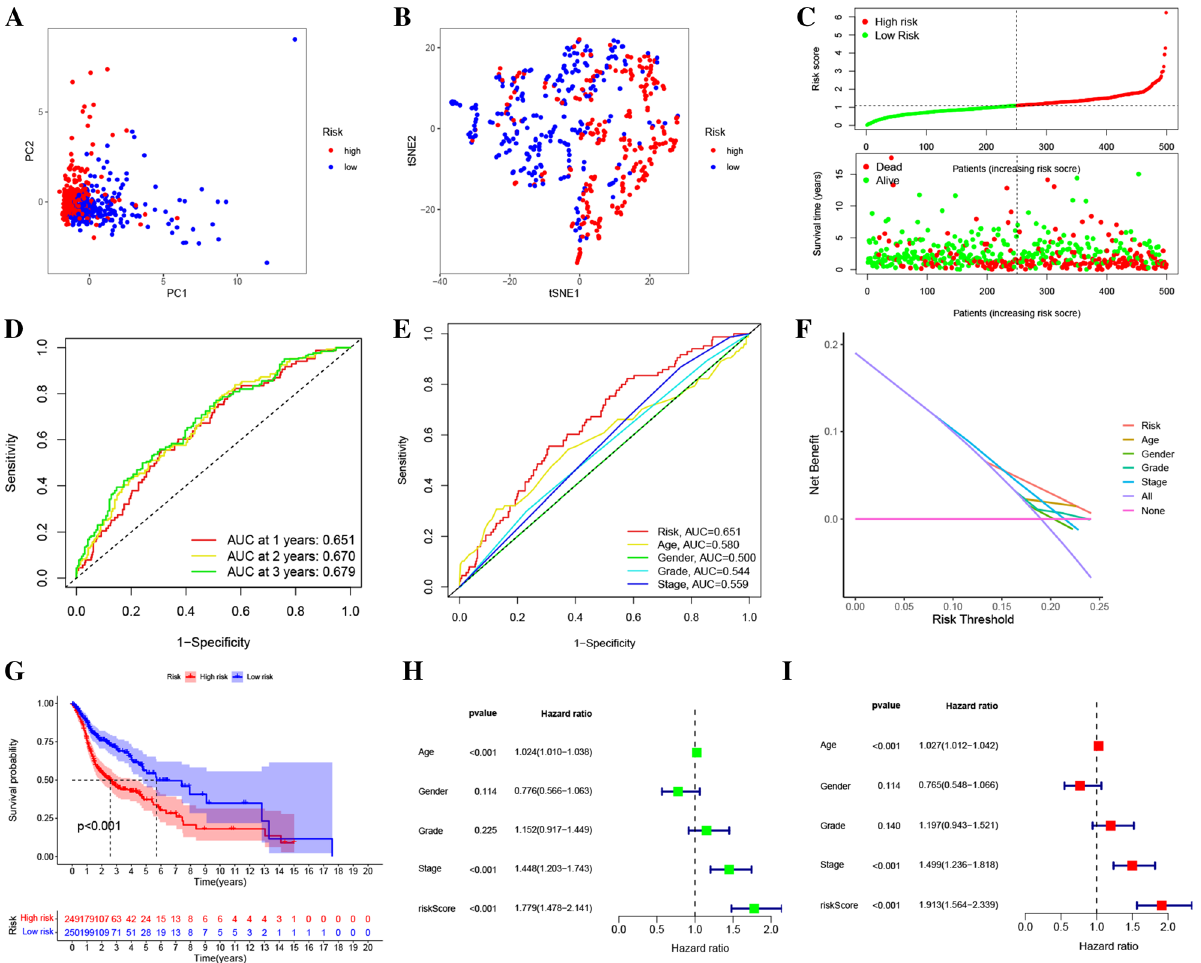
Figure 3. Redox-related lncRNAs prognostic signature constructed using TCGA. ( A ) The PCA plot. ( B ) The t-SNE plot. ( C ) Plot of risk survival status ( D ) The AUC of the signature for predicting the survival rates of HNSCC patients over one, two, and three years. ( E ) The AUC values of the risk factors. ( F ) The DCA of the risk factors. ( G ) Survival analysis using the Kaplan–Meier method for low and high cohorts. ( H ) Univariate Cox analysis of the signature. ( I ) Multivariate Cox analyses of the